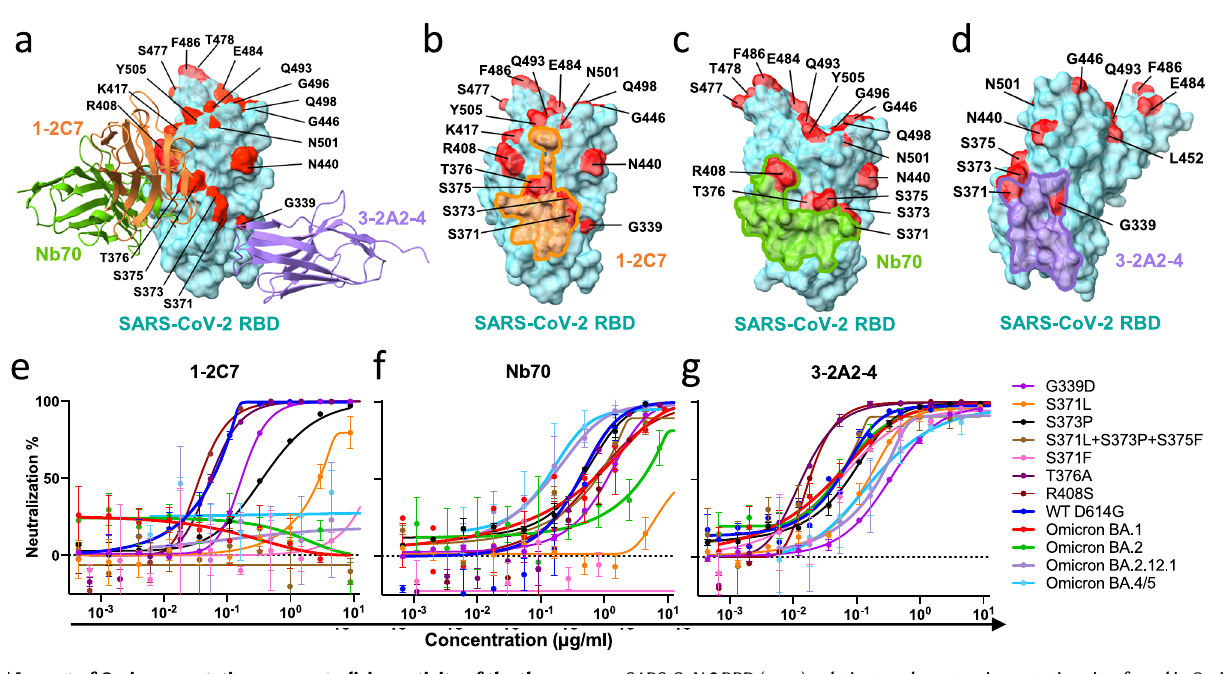
Fig. 4 | Impact of Omicron mutations on neutralizing activity of the three representative nanobodies. a Binding modes of 1-2C7 (orange), Nb70 (green), and 3-2A2-4 (purple) to prototype SARS-CoV-2 RBD with the relevant major mutationsitesfoundinOmicronsubvariantshighlightedinred. b ‒ d Thefootprints of 1-2C7 (orange), Nb70 (green), and 3-2A2-4 (purple) on the surface of